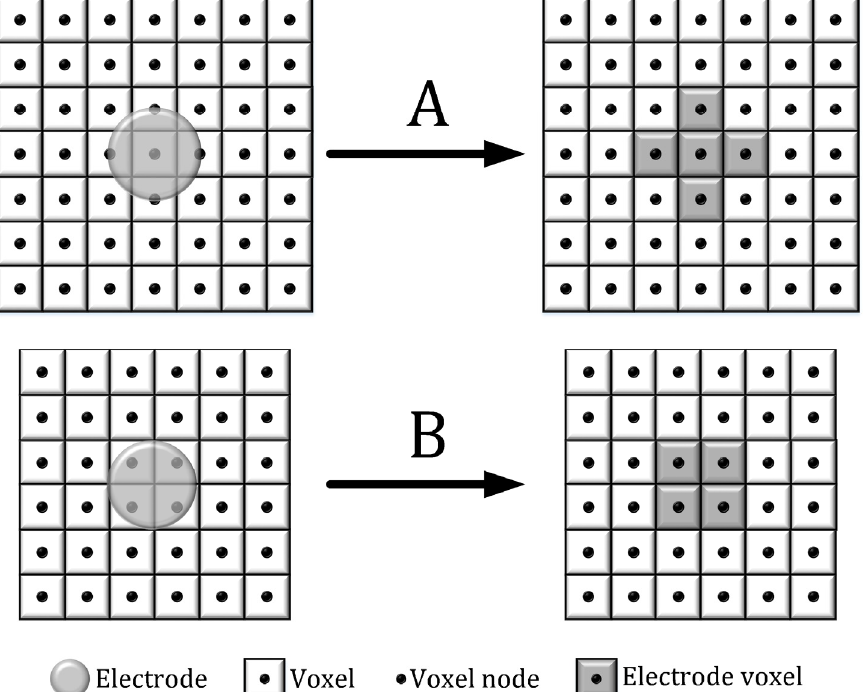
Figure 1. Examples of the discretization of cylindrical electrodes within a uniform rectangular ( A ) centralized grid, and ( B ) shifted grid. This illustration assumes a 1 × 10 − 3 m diameter electrode and a 0.5 × 10 − 3 m voxel size. The voxel size is varied during this study.